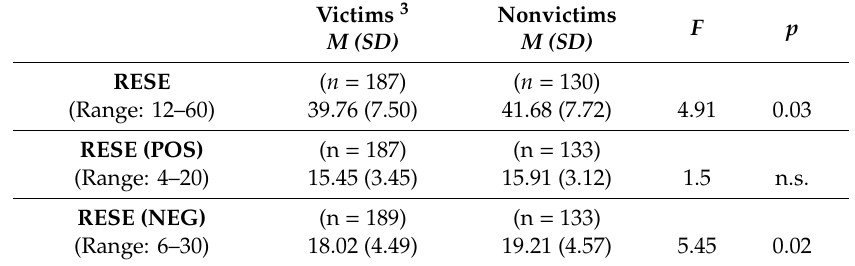
Table 3. Regulatory emotional self-e ffi cacy: comparison between victims and nonvictims (one-way ANOVA). Victims